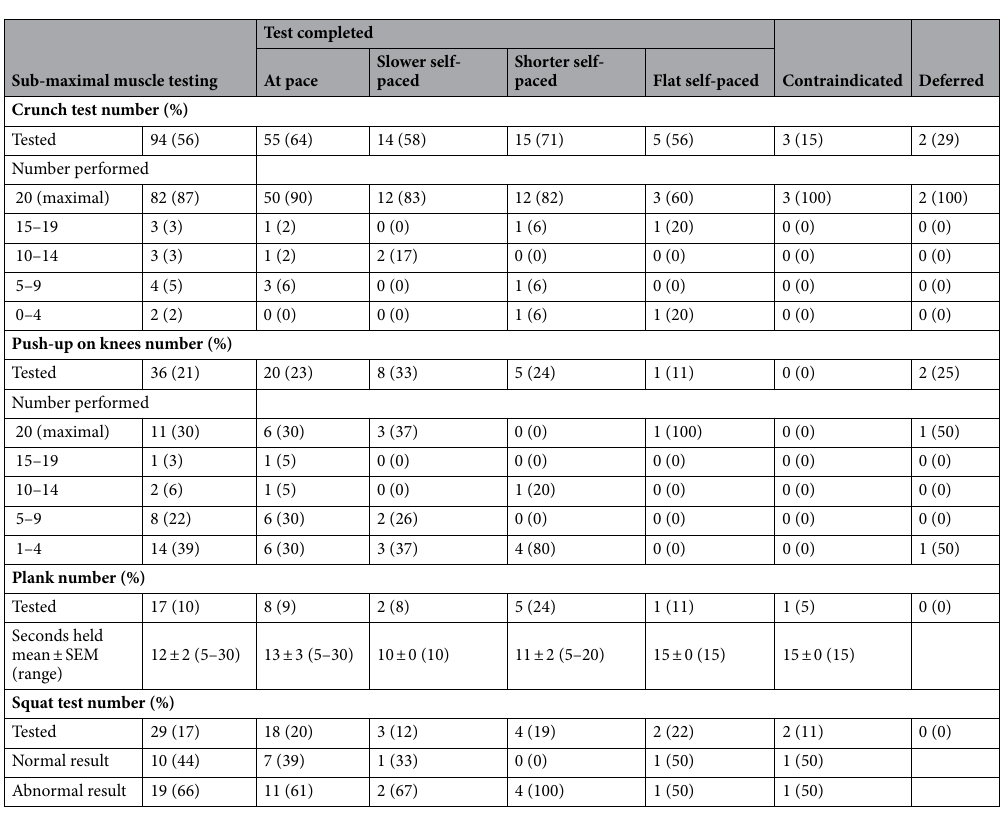
Table 6. Strength test performance. SEM: standard error of the